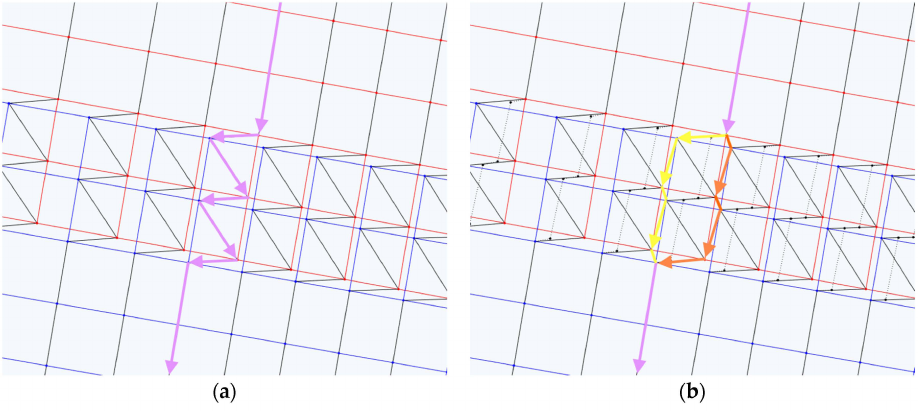
Figure 8. ( a ) Geo-locations around the transition from the 3:1 to the 2:1 sample aggregation scheme; magenta path connects interleaved footprints from different scans; ( b ) two alternate geo reordering schemes, involving column shifts, marked by yellow and orange paths.